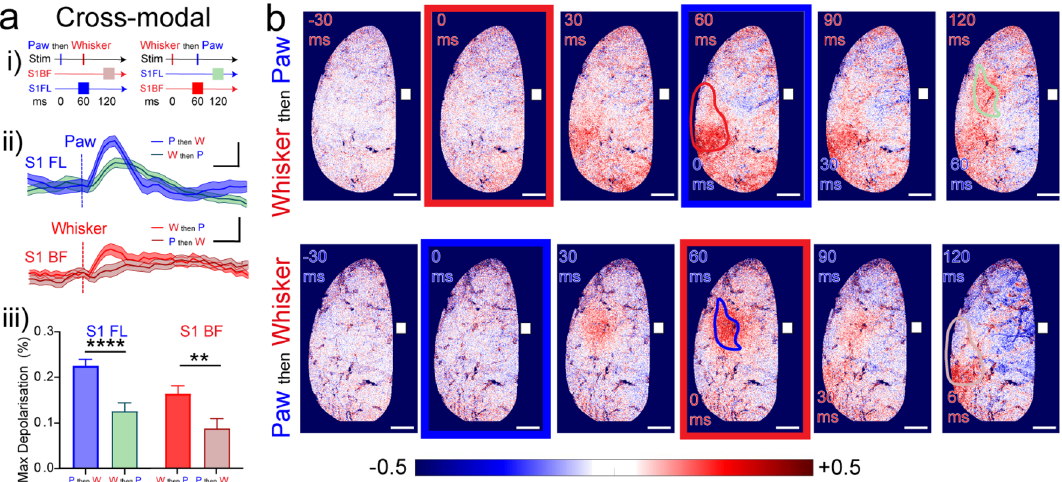
Figure 2. Cross Modal Inhibition evoked by Whisker and Paw Stimulation (“Results”; “Discussion”). ( a ) Cross-modal sensory stimulation. (i) Timeline of the cross-modal sensory stimulation. In “paw then whisker (P then W)” experiments the forepaw was stimulated first and then 60 ms later an air puff was delivered to the mouse whiskers. Blue bar represents the time of the peak S1FL response, 60 ms after stimulation. Pink bar represents the time of the peak S1BF response 60 ms after stimulation, ie 120 ms. In “Whisker then Paw (W then P)” experiments the whisker was stimulated first and 60 ms later a light stimulation was delivered to the forepaw. Red bar represents the time of the peak S1BF response, 60 ms after stimulation. Green bar represents the time of the peak S1FL response 60 ms after stimulation, ie 120 ms. (ii) Sensory-evoked voltage responses spatially averaged across S1FL after Paw stimulation, of “P then W” (blue trace) and of “W then P” (pale green trace), note the reduced amplitude of the paw-evoked response when stimulated after the whiskers (pale green trace). Sensory-evoked voltage responses spatially averaged across S1BF after Whisker stimulation, of “W then P” (red trace) and of “P then W” (pale red trace). Note the reduced amplitude of the whisker-evoked response when stimulated after the paw (pale red trace). Scalebar 0.1% ΔR/R and 50 ms. (iii) Maximum depolarization amplitude in S1FL from “P then W” and “W then P” trials and in the S1BF in “W then P” and “P then